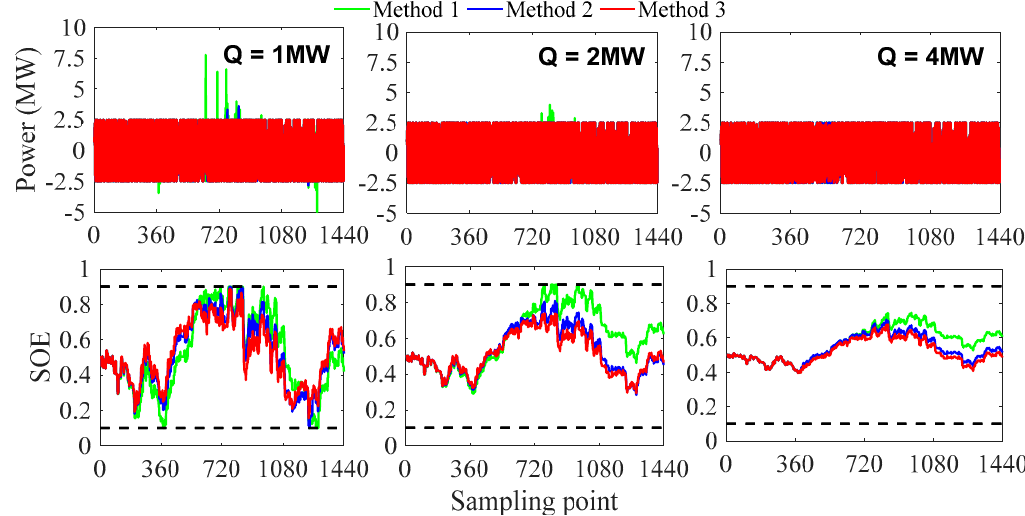
Figure 13. Comparison curve of Δ P G and SOE with three methods under different Q .